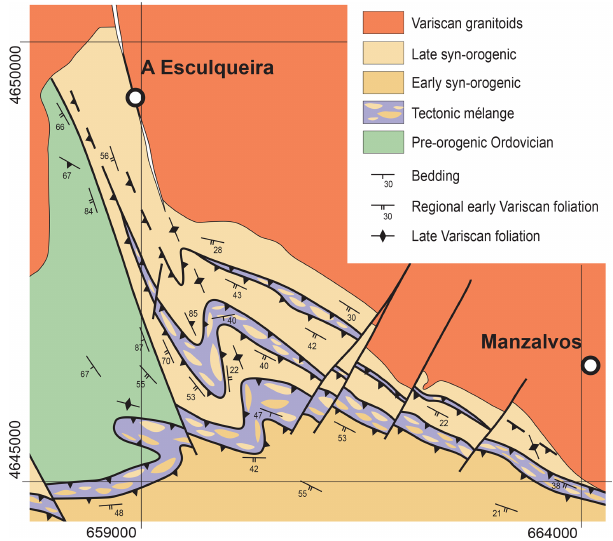
Figure 9. Geological sketch of one area north of the Bragança Complex showing slices of synorogenic units bounded by tectonics mélanges involving the synorogenic and the black Silurian rocks. The multiplex was openly folded during the Late Variscan event (C 3 ). Coordinates system: